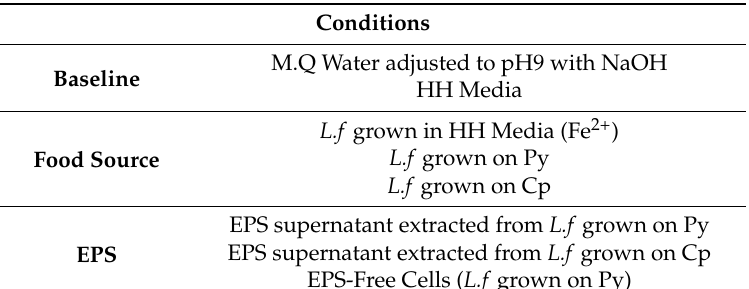
Table 1. Conditioning of samples at an exposure time of 24 h, 48 h, and 72